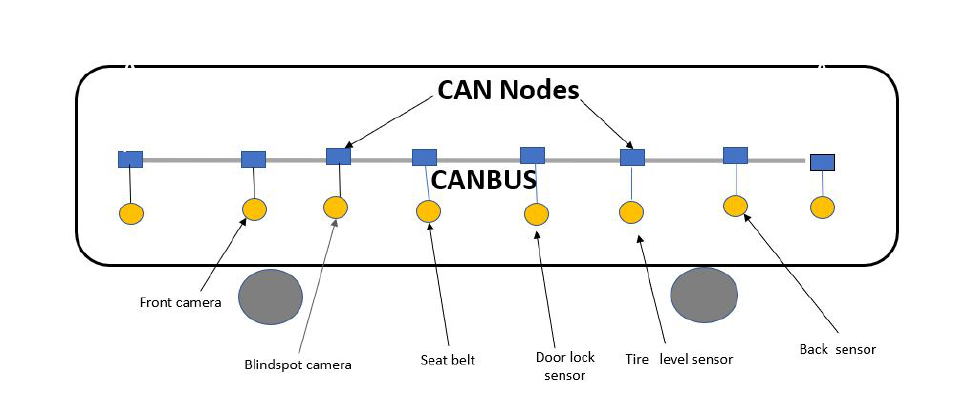
Figure 1. Traditional CANBUS layout.